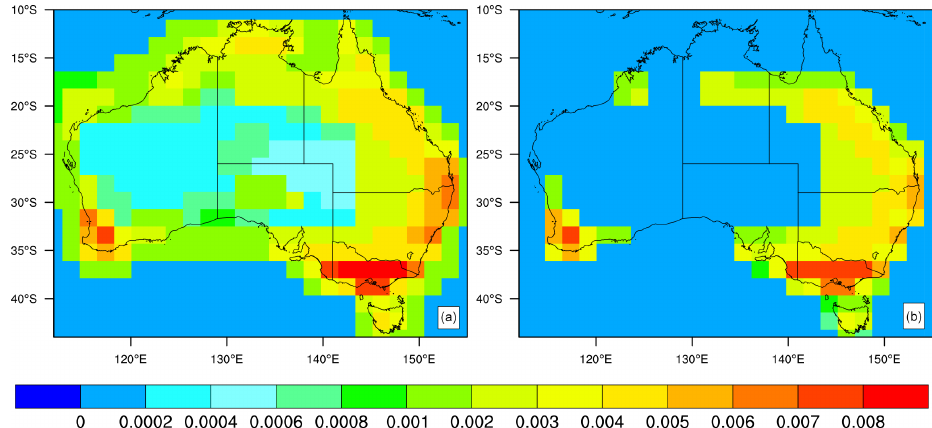
Figure 2. Prior CH 4 flux uncertainties (1 standard deviation) in grams carbon per square metre per week at 1.8 ◦ resolution for (a) the total and (b) ruminant land animals only. The seasonality of the wetland fluxes is not shown here in the